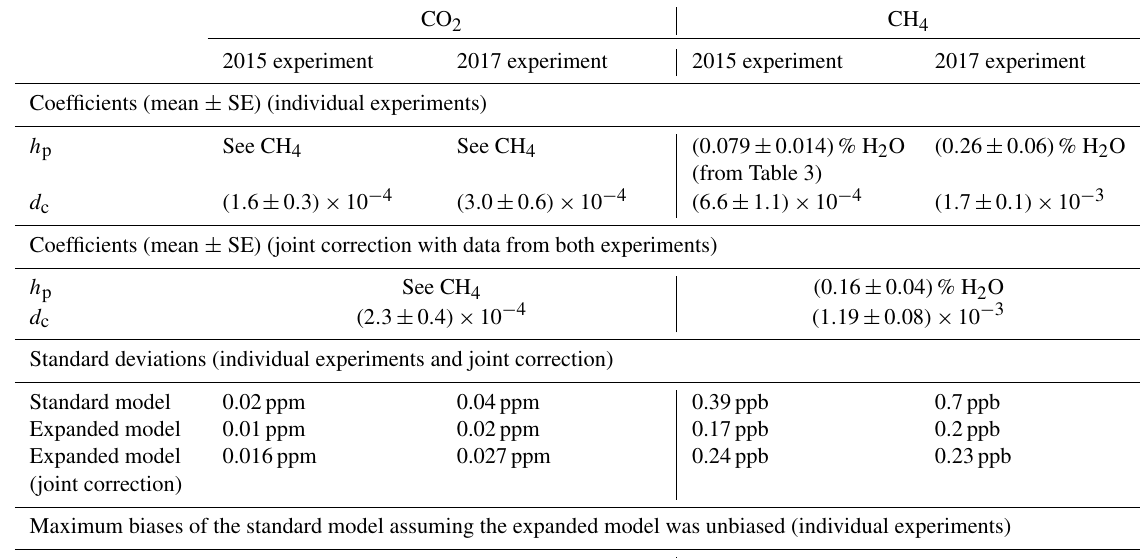
Table 7. Comparison of water corrections of the two experiments with Picarro no. 5. The bias estimates of the standard model are based on the assumption that the results of the expanded model were unbiased.